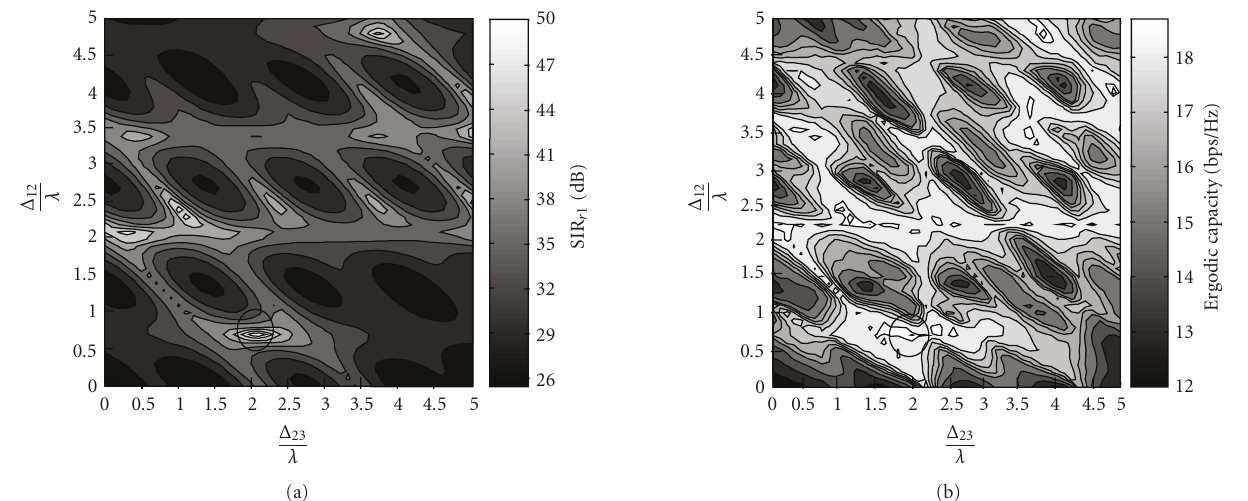
Figure 7: Setting-B: rank-1 approximation (a) of the signal-to-interference ratio SIR r 1 ( Δ , η ) versus Δ 12 /λ and Δ 23 /λ . Circular marker de- notes the optimal solution (24) obtained by the rank-1 approximation. As a reference, ergodic capacity is shown (b), for an angular spread approaching